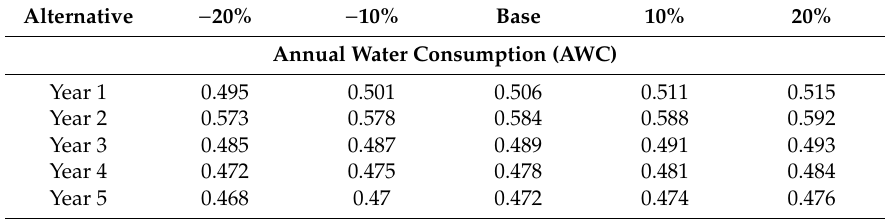
Figure A3. Sensitivity analysis combining judgements from the expert and the patient group. Table A1. Sensitivity analysis results modifying expert and patient group combined weights.